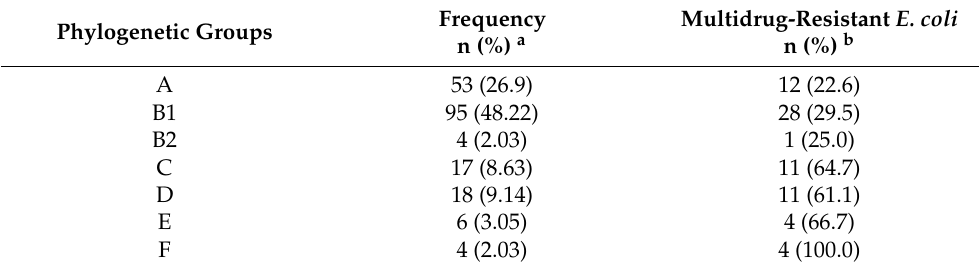
Table 4. Prevalence of phylogenetic groups in E. coli and multidrug-resistant E. coli in respective phylogenetic group. Phylogenetic Groups